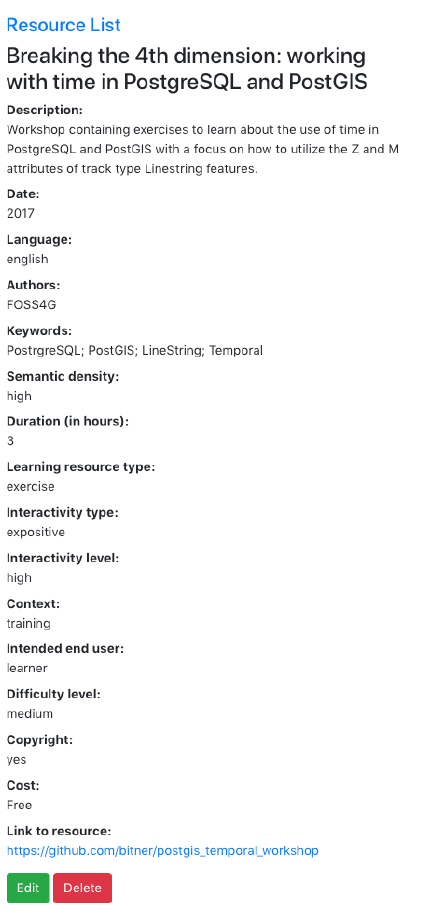
Figure 4. Viewing the metadata of a